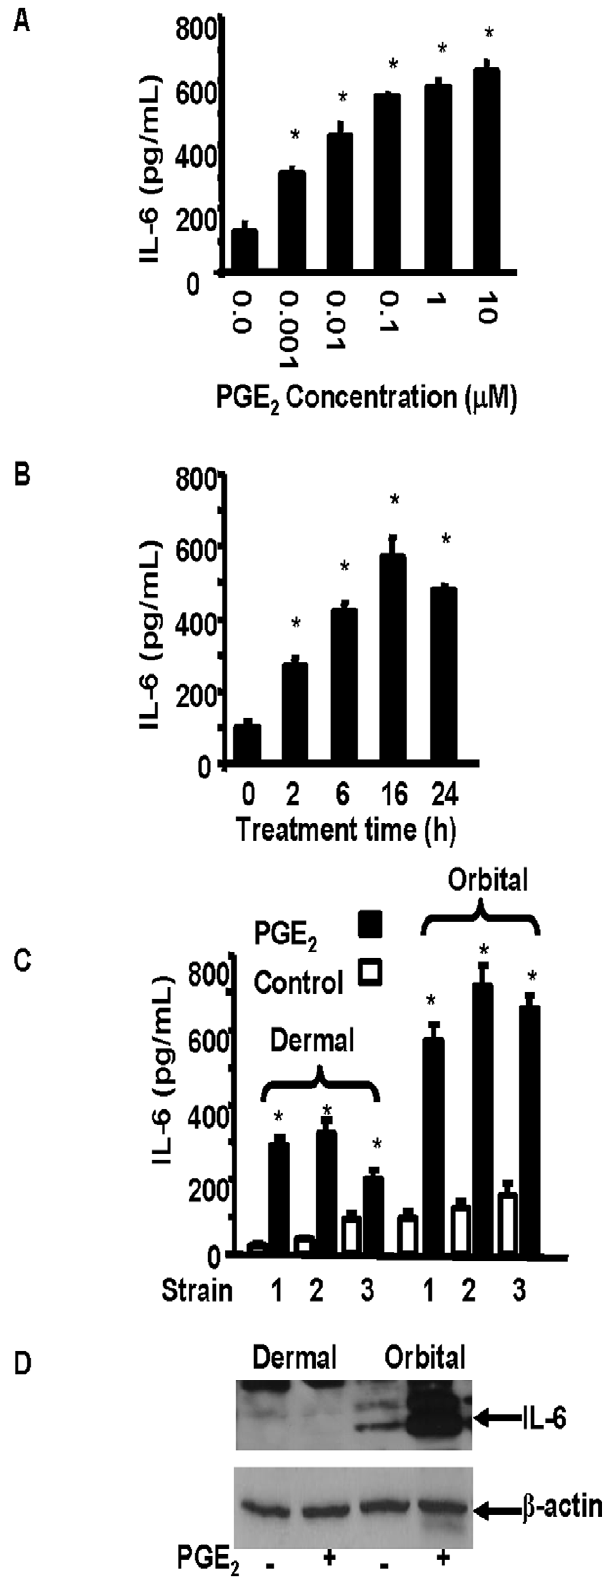
Figure 1. IL-6 production in orbital fibroblasts is induced by PGE 2 in a concentration- and time-dependent manner. Conflu- ent orbital cultures, in this case from a patient with TAO, were